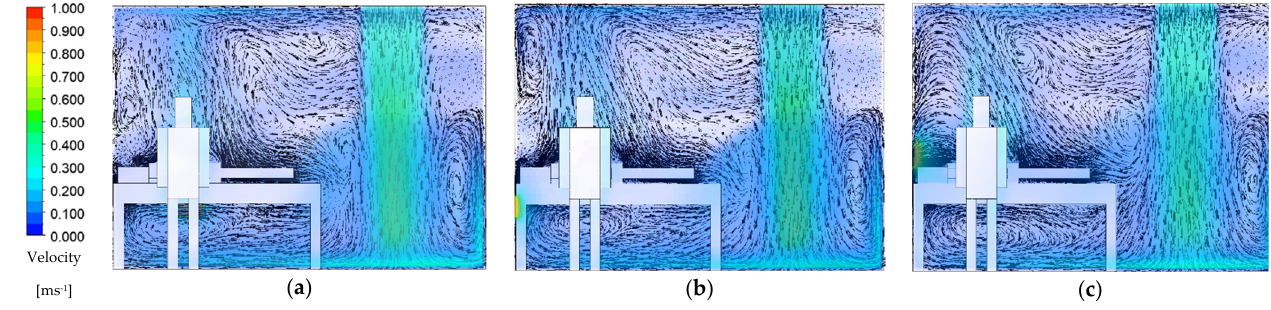
Figure 4. Airflow distribution pattern at 480 s: ( a ) case 1 (existing model); ( b ) case 2; ( c ) case 3.